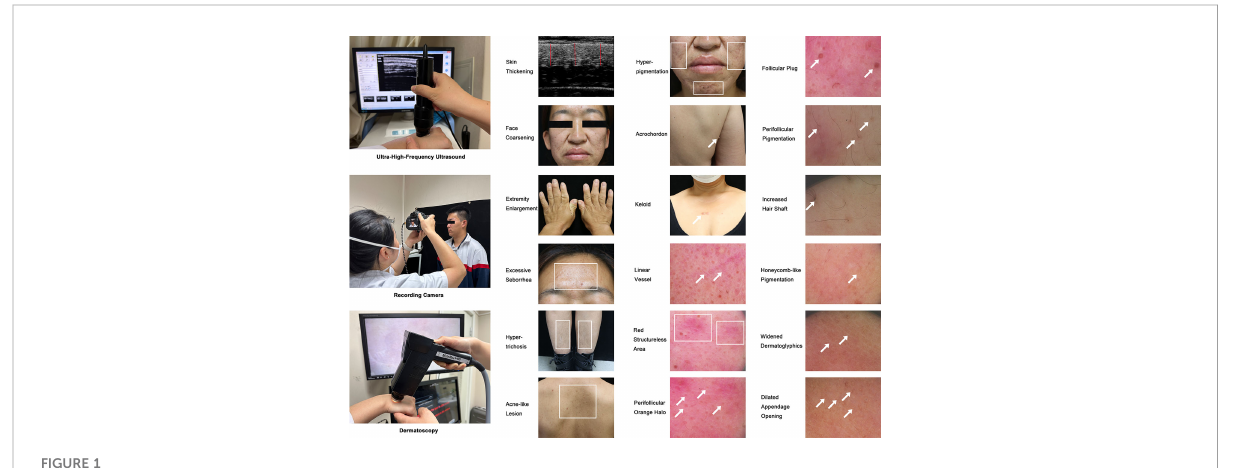
FIGURE 1 Ultrasonic, Megascopic, and Dermatoscopic Skin Presentations of Acromegaly. This fi gure shows the devices including UHFUS, camera, and dermatoscopy utilized to assess acromegaly-related cutaneous manifestations in this study and contains 18 representative images showing the sub- and macroscopic skin lesions of acromegaly patients. The illustrated cutaneous manifestations include thickened skin (compared with the controls using the UHFUS), face coarsening, extremity enlargement, excessive seborrhea, hypertrichosis, acne-like lesion (on the upper back), hyper-pigmentation (on the face), acrochordon, keloid, and sub-macroscopic skin lesions shown by dermatoscopy (linear vessel, red structure area, perifollicular orange halo, follicular plug, perifollicular pigmentation, increased hair shaft, honeycomb-like pigmentation, widened dermatoglyphics, and dilated appendage opening). Arrows and rectangles were used to highlight the typical skin